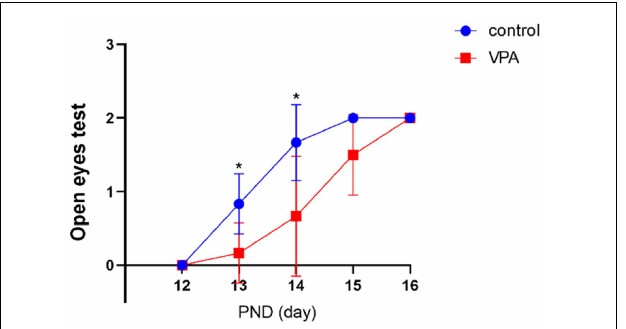
TABLE 1 | Primer sequences.